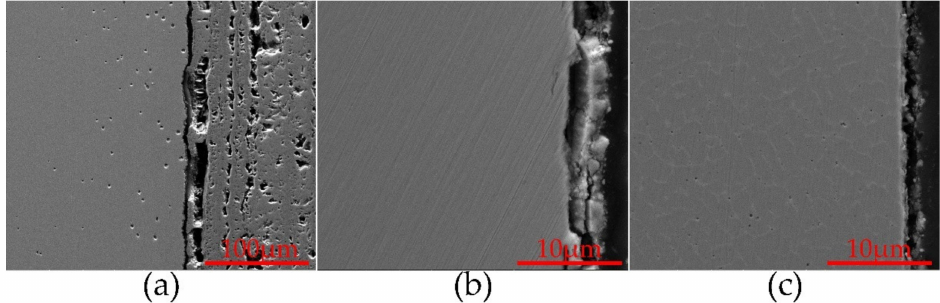
Figure 7. SEM cross-sectional micrographs of: ( a ) 20G steel; ( b ) C22 alloy; ( c ) C22 laser coating corroded in reducing atmosphere for 108 h at 450 ◦